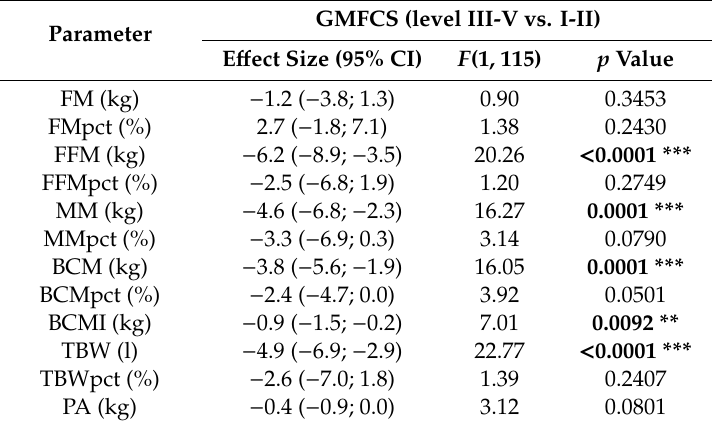
Table 5. Selected components of body composition in the children with CP relative to motor function level according to GMFCS.